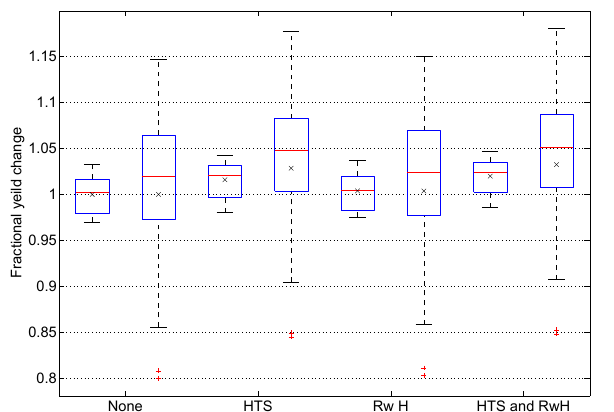
Figure 6. Efficacy of adaptation methods for maize in GLAM. HTS is crops adapted to high-temperature stress, Rw H shows crops with rainwater harvesting, and HTS and Rw H shows both adaptation methods in use. Each box shows the fractional yield change relative to the unadapted crop with the box plots showing the range across the six-member GCM–RCM ensemble. The pairs of boxes show the relative change in yield for the adaptation method in the historic climate (left) and the future climate